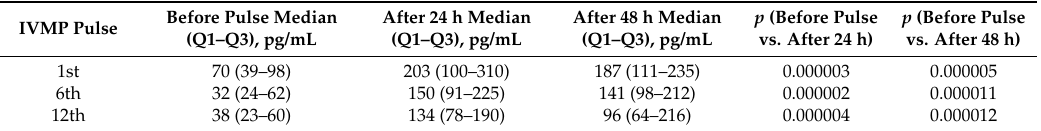
Table 3. Changes in N-terminal pro-brain natriuretic peptide levels during selected IVMP pulses (N = 32).